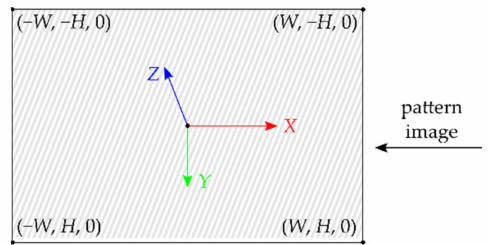
Figure 1. Definition of the four coordinates of the pattern image in the world coordinate